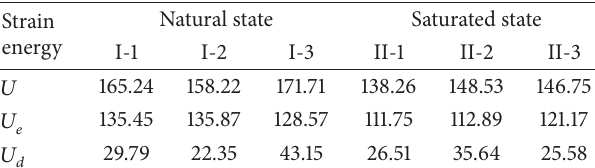
Table 1: Strain energy at peak stress point under uniaxial compres- sion test (kJ ⋅ m −3